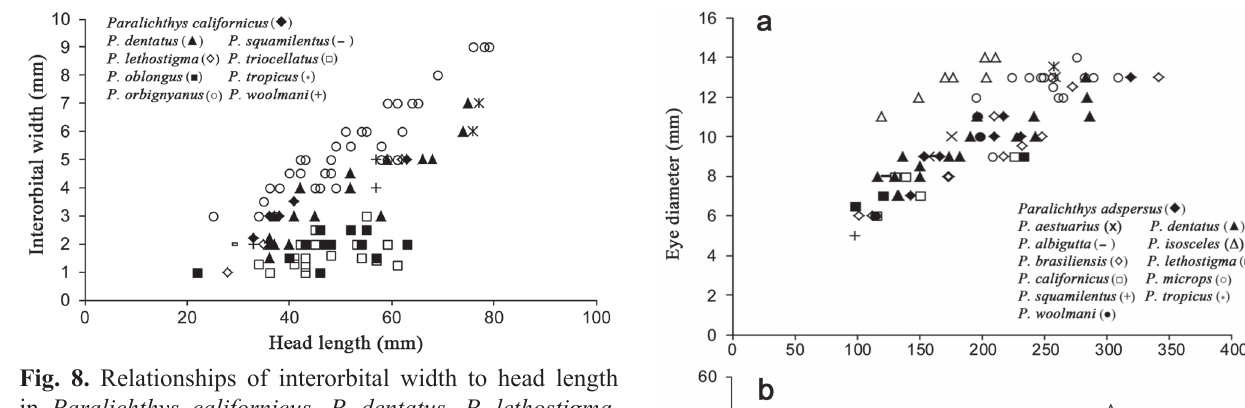
tropicus and P. woolmani , P. californicus